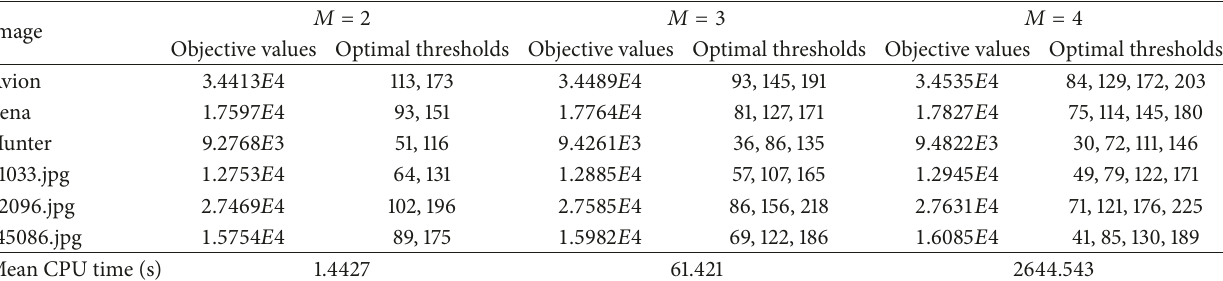
Table 4: Objective values and thresholds by the Otsu